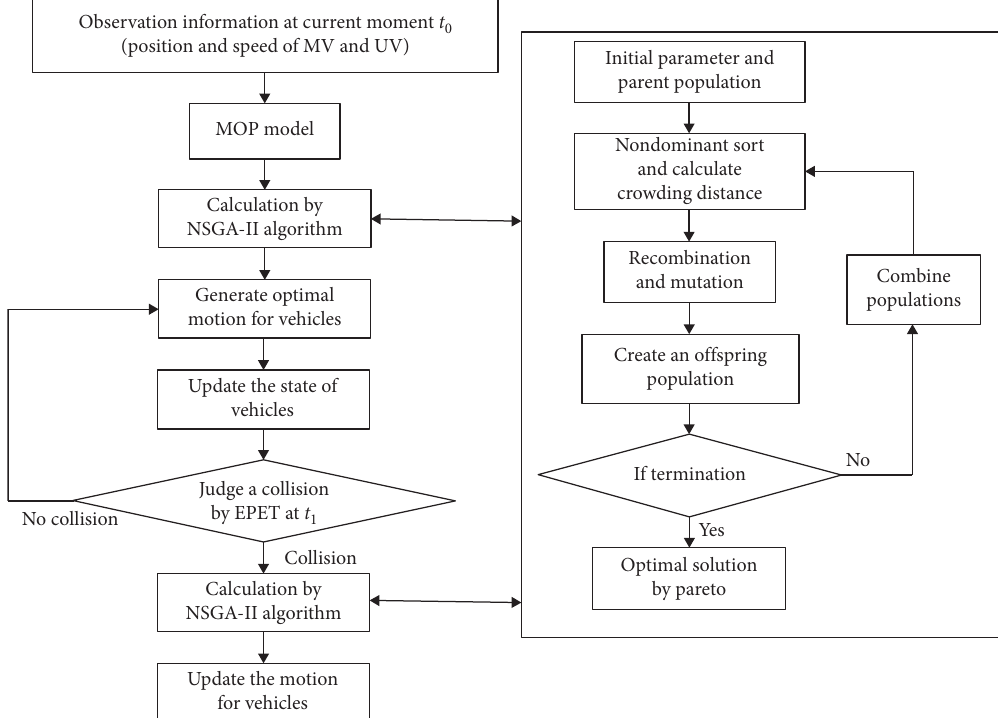
Figure 6: Process of the MOP model at intersections by the NSGA-II